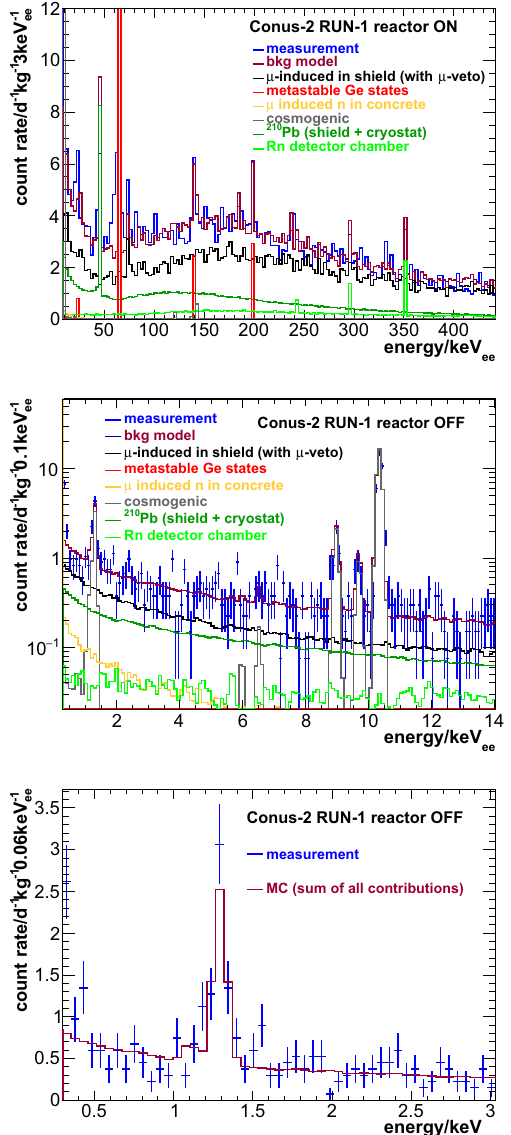
Fig. 20 ThemeasuredbackgroundspectrumofC2isdepictedtogether with the background model in the highE range and lowE range and an even smaller energy range focusing on the ROI for CE ν NS. The MC spectra from the various background sources are shown in differ- ent colors. The strong increase within the lowE range below 400eV ee is attributed to noise and is fitted with an exponential two-parameter model. For the highE range, reactor ON data were used, as no reactor OFF data are